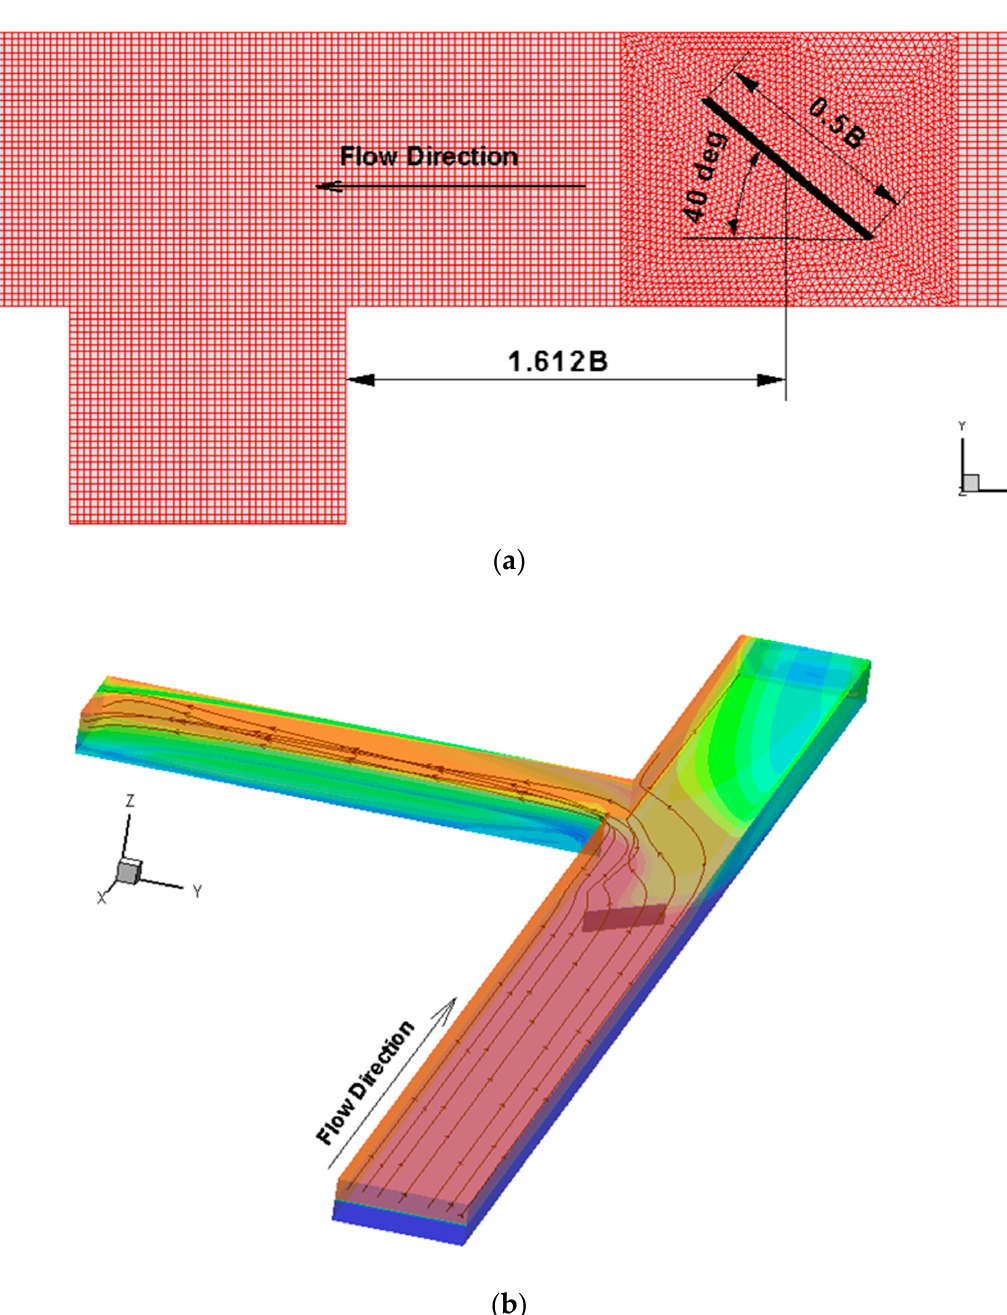
Figure 11. Schematic of the straight vane placed in the middle of the main channel upstream of the juncture with 40 ° angle from the flow direction; ( a ) the model domain and mesh showing location, orientation, and dimensions of the vane; ( b ) the predicted fish distribution function field and flow streamlines on the mid-horizontal plane.